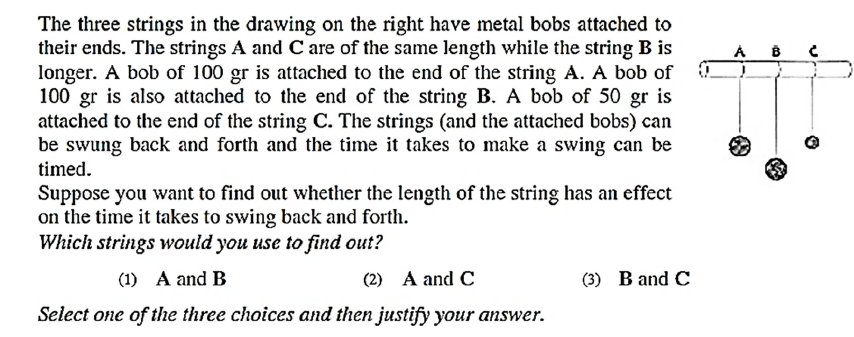
Figure A3. Sample item from the Field dependence/independence test.